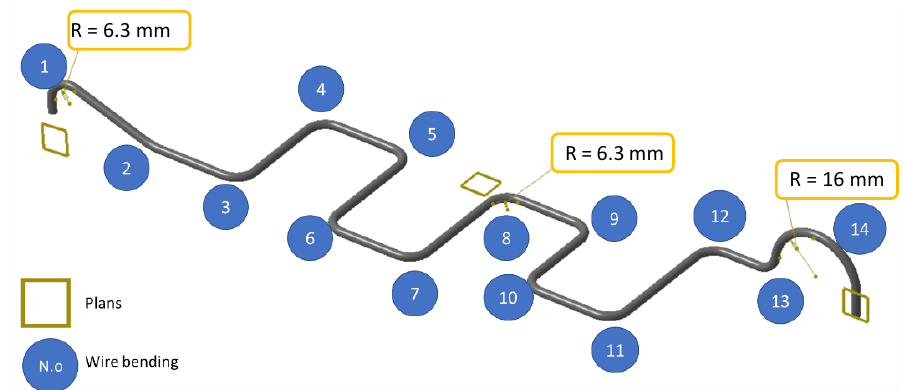
Figure 16. Typical cushion wire.